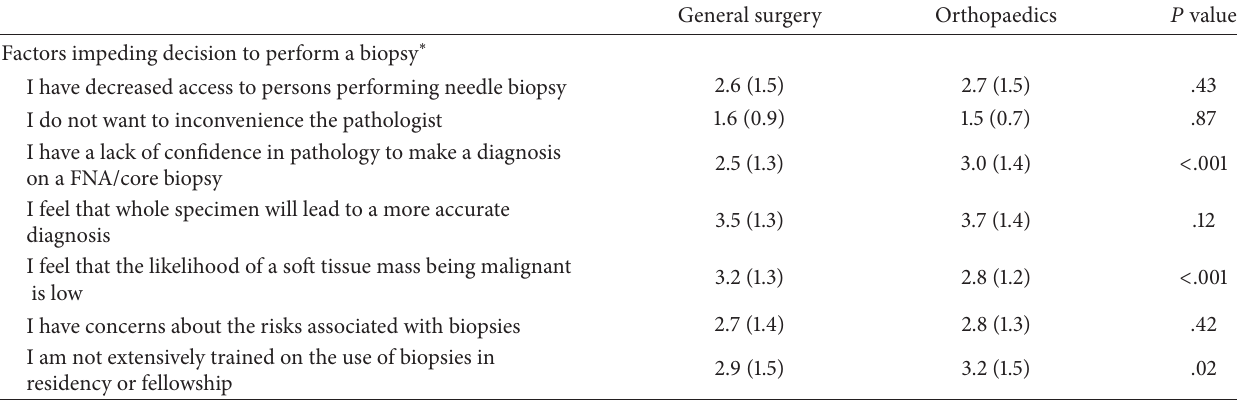
Table 4: Rating of factors that impede a resident’s decision to perform a biopsy prior to excision. General surgery